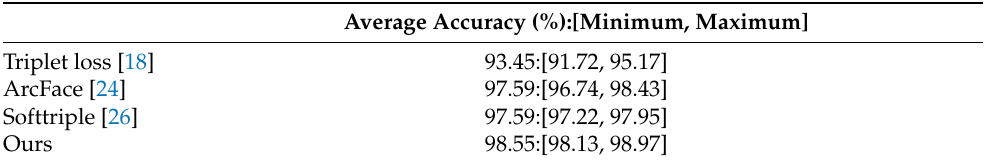
Table 3. Results on CNSID100 with 50% individuals unseen.